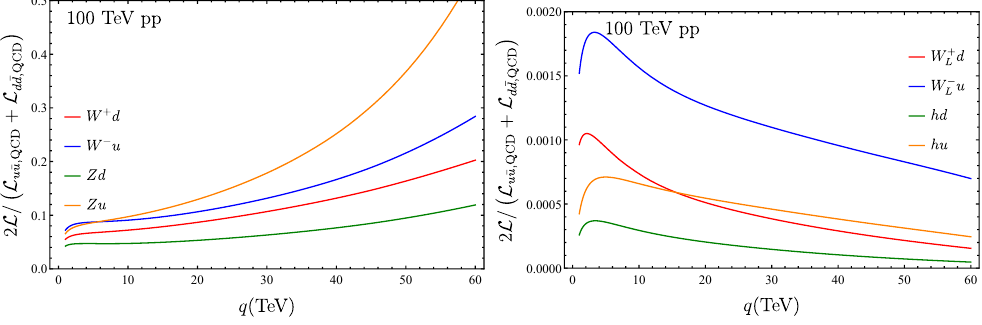
Figure 7 . V q and Hq luminosity in the full unbroken SM, divided by the average of u (cid:22) u and d (cid:22) d luminosity assuming pure QCD evolution only.